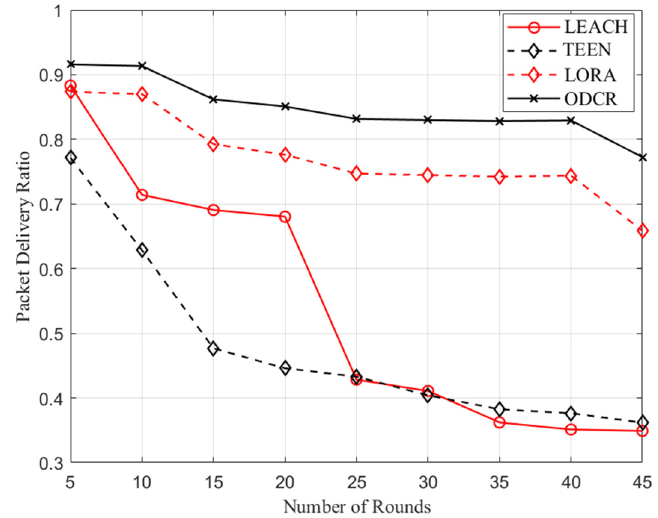
Figure 11. Comparison of packet delivery ratio.